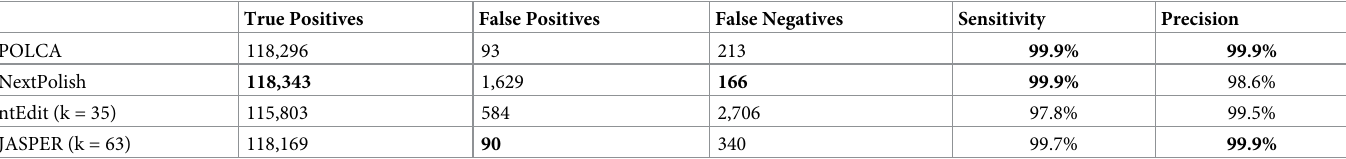
Table 2. Statistical analysis of the corrections made by different polishing methods on an A . thaliana with simulated errors using simulated reads. True Positives are errors that we introduced and that were corrected; False Positives are spurious corrections that polishers made where there were no errors introduced; and False Nega- tives are errors in the genome that were not corrected. The best numbers in each column are in bold. JASPER is the most accurate polisher with the lowest number of False